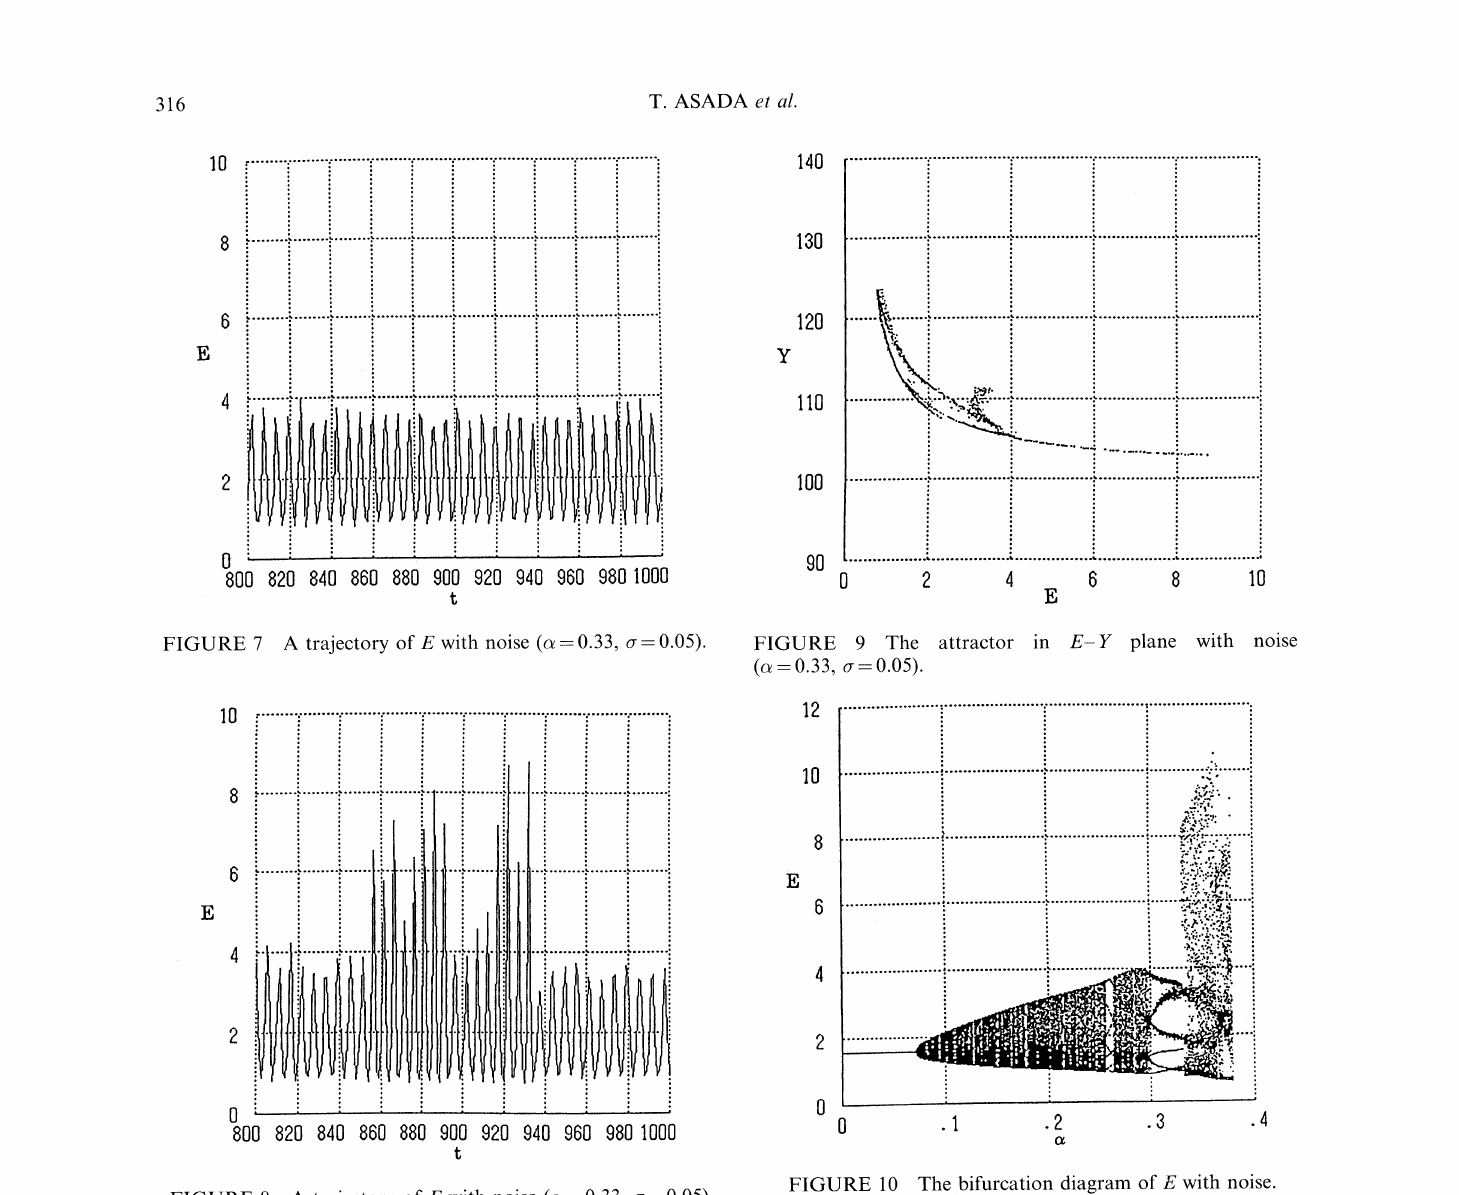
FIGURE 10 The bifurcation diagram of E with